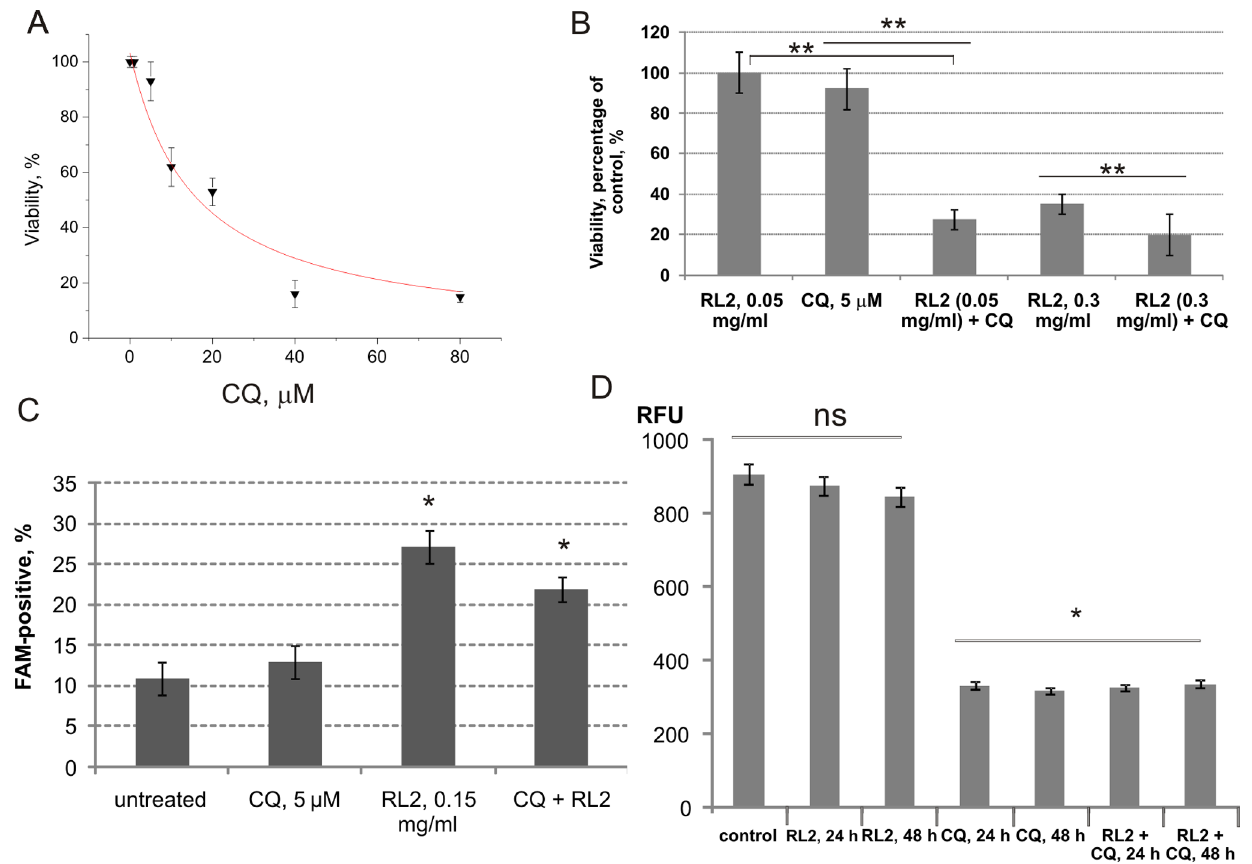
Figure 6. Enhanced cytotoxic outcome in combination of RL2 with CQ. MDA-MB-231 cells were used as a model. A . Dose-dependence of CQ cytotoxicity was calculated using MTT data of three independent experiments. Shown are mean values 6 SD. B . Cells were treated with different concentrations of RL2 in the presence or absence of CQ, and after 48 h cell viability was measured by MTT assay. C . Cells were incubated with RL2 (0.2 mg/mL), CQ (5 m M) or a combination for 24 h and the percentage of cells with active caspase -3,-7 was analysed using flow cytometry. Shown are mean values 6 SD of three independent experiments. The asterisks indicate significant difference from control (*, p , 0.05). D . Cells were incubated with RL2 (0.2 mg/mL), CQ (5 m M) or a combination for 24–48 h. Cathepsin D activity was analysed using a fluorescence substrate (labeled with methyl cumaryl amide) by fluorimetry as described in ‘Materials and methods’ section. RFU – relative fluorescence units per microgram protein of sample. Shown are mean values 6 SD of three independent experiments. The asterisks indicate significant difference between indicated groups (**, p , 0.05), ns - not significant difference between groups (p . 0.05).